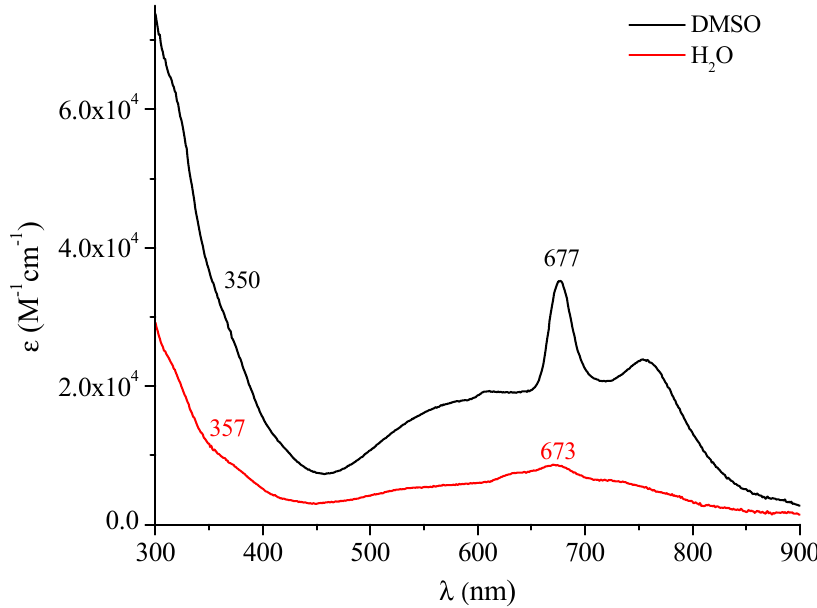
Figure 9. UV-visible spectra in the range 300–900 nm of the complex. [(2-Mepy) 8 TPyzPzIn(OAc)] (I) 8 · H 2 O in DMSO and H 2